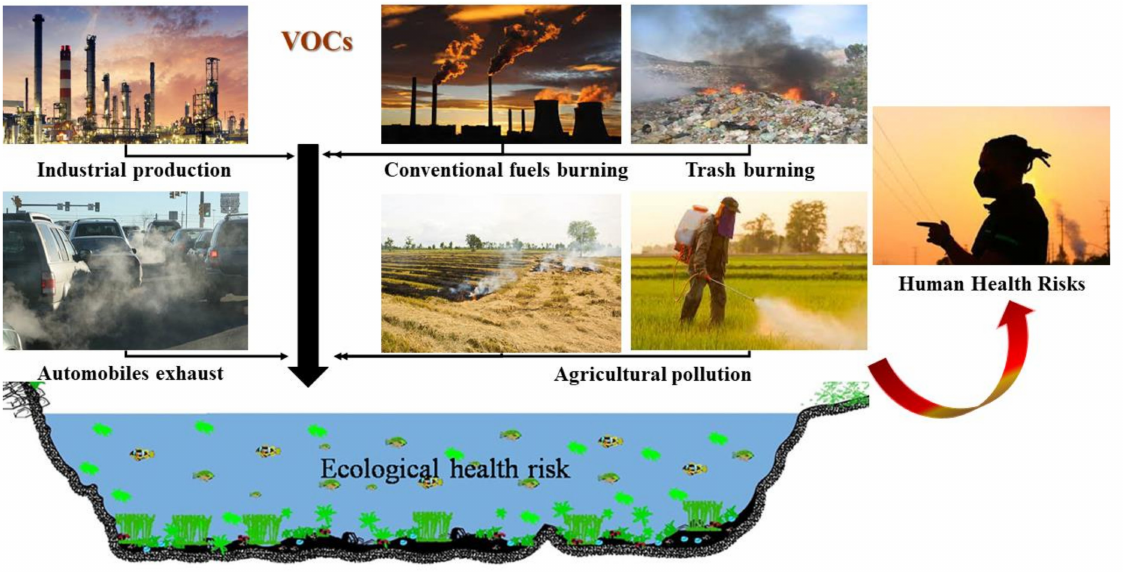
Figure 1. Potential sources of VOC